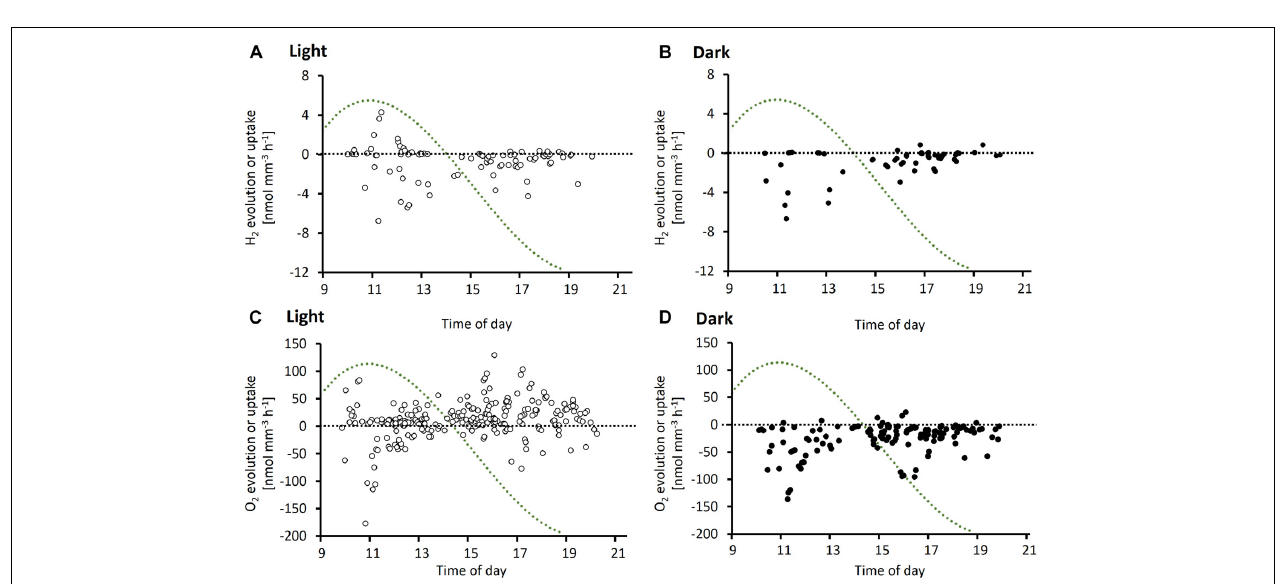
FIGURE 1 | (A) Trichodesmium colony during a microsensor measurement. O 2 sensor and H 2 sensor as well as the glass needle and nylon mesh holding the colony in place are shown. The size of the colony core as used for flux calculations is indicated by the bracket. (B) Example of O 2 and H 2 depth profiles measured simultaneously on the same colony. Measurements were performed in the dark after H 2 addition. Gray shading indicates the approximate area taken by the colony core, the center of the colony is approximately at depth –70 µ m. The gray line shows an example of a linear fit to the O 2 gradient at the colony surface. The slope of this line gives (cid:49) C/ (cid:49) r which is used to calculate the flux of O 2 across the colony surface according to Eq. 4.